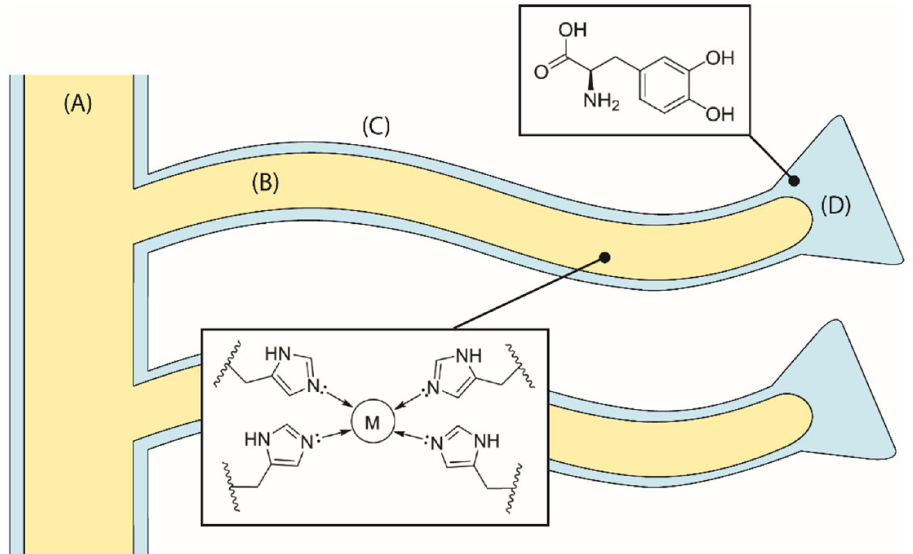
Figure 1. Schematic representation of the byssus. ( A ) The stem, ( B ) the thread core, ( C ) the cuticle, and ( D ) the plaque. In yellow, the collagen- and His-rich regions while, in blue, the DOPA-rich ones are